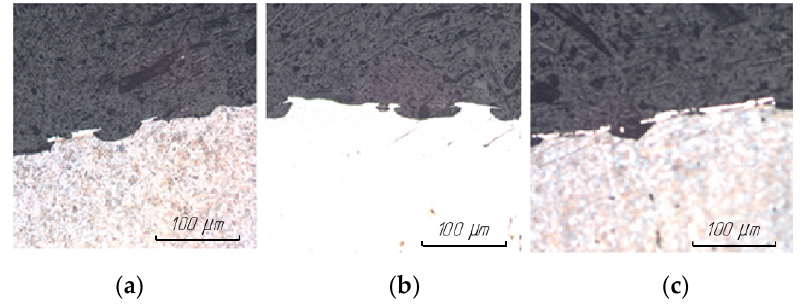
Figure 12. Surface structure of steel 15 at 100× magnification after EDM in ET finishing mode from: ( a ) copper; ( b ) graphite; ( c ) composite.